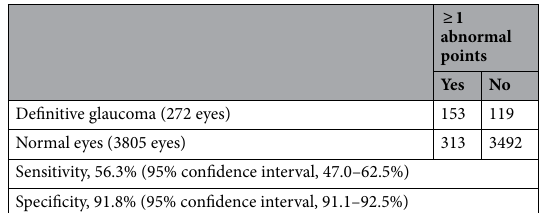
Table 1. Sensitivity and specificity in glaucoma and normal